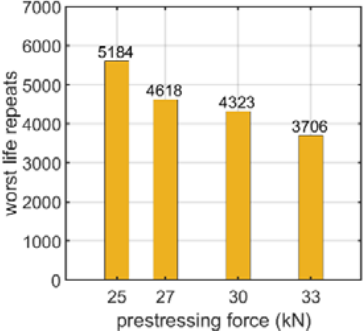
Figure 12. Number of logarithmic life repeats for prestressing force parametrization of the bolt with a nut connection.